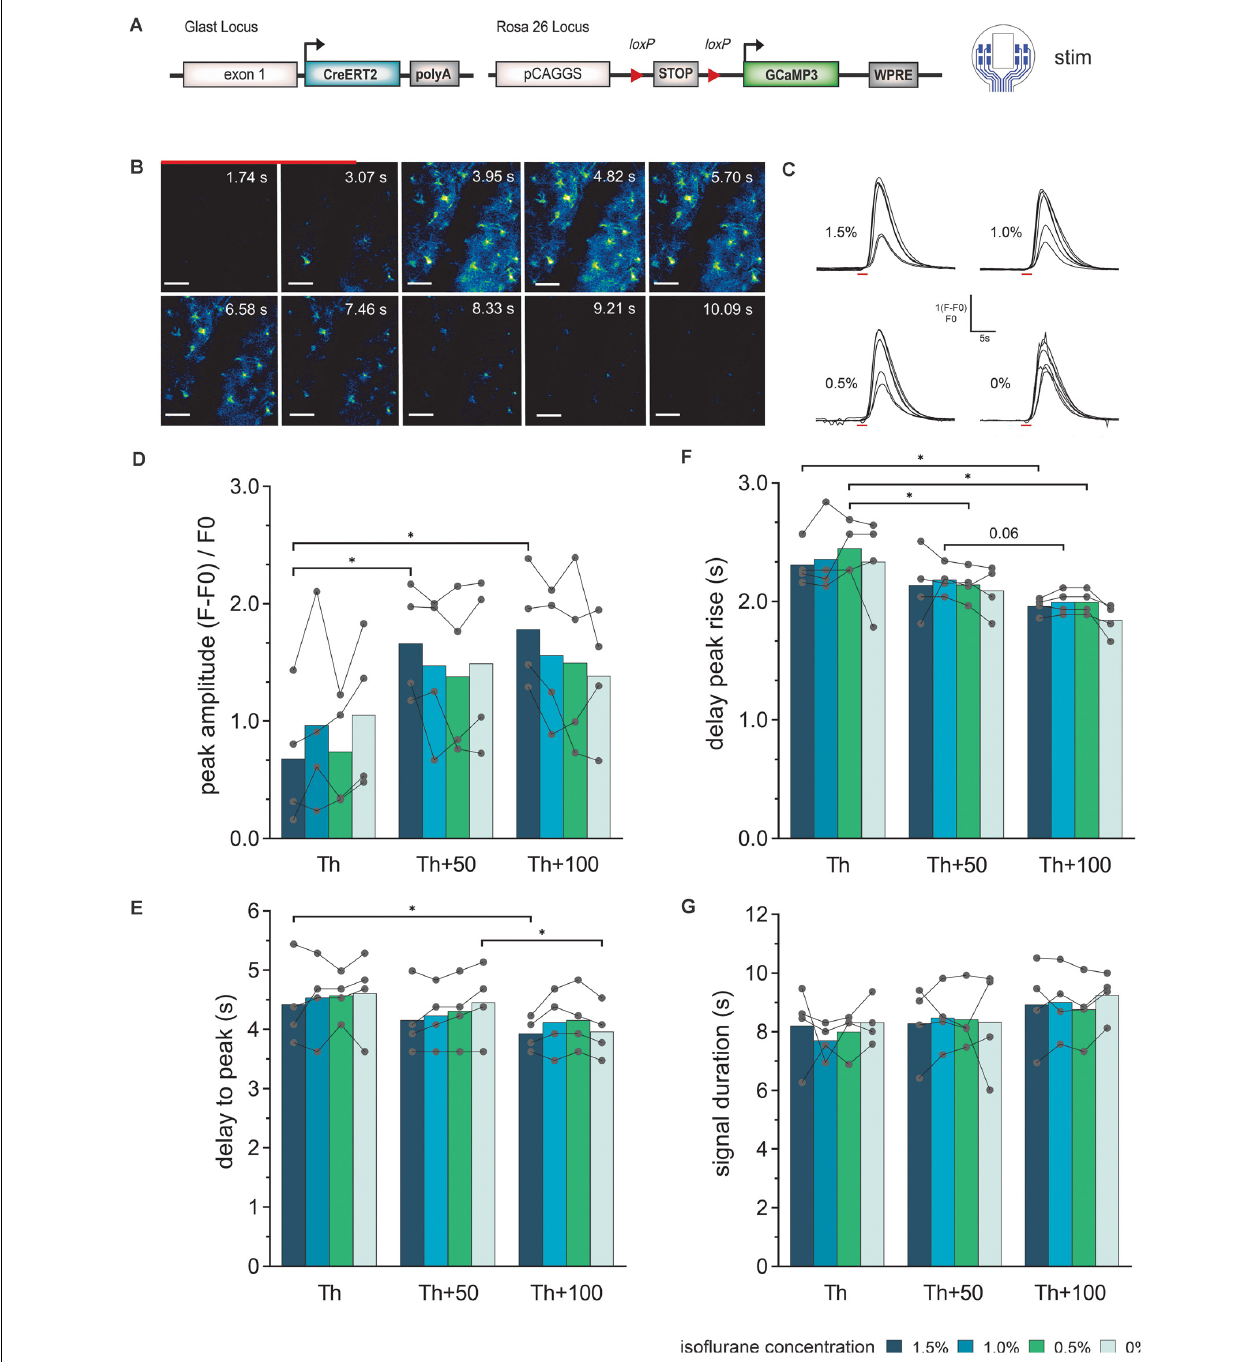
FIGURE 4 | Astroglial Ca 2+ -signal elicited by electrical stimulation via the LCP surface electrodes and recorded by in vivo 2P imaging. (A) The experiment was performed in transgenic mice expressing the Ca 2+ sensor GCaMP3 in astrocytes and cortical stimulations were applied with the 8-channel stimulation electrode. (B) 2P-Ca 2+ imaging sequence during electrical stimulation (red bar), scale bar = 50 µ m. (C) Astroglial Ca 2+ transients in response to electric stimulation (red bar) display a single, uniform peak at all tested isoflurane concentrations (1.5–0%). (D) The Ca 2+ peak amplitude increases with increasing stimulation intensity, especially at high isoflurane concentrations (1.5%), while no significant effect of changing anesthesia levels at the same stimulation intensity could be detected. (E) The delay from stimulation onset to Ca 2+ peak decreases with increasing stimulation intensities but is independent of isoflurane levels. (F) Rise of the Ca 2+ transient to 10% of its maximum was reduced by increasing the stimulation current without changing at varying anesthesia levels of the same current intensity. (G) The astroglial Ca 2+ signal duration was independent of stimulation intensity and anesthesia. Statistics: Two-Way ANOVA followed by Tukey’s multiple comparisons test ∗ p < 0.05, N = 4 measurements per stimulation intensity. Th,